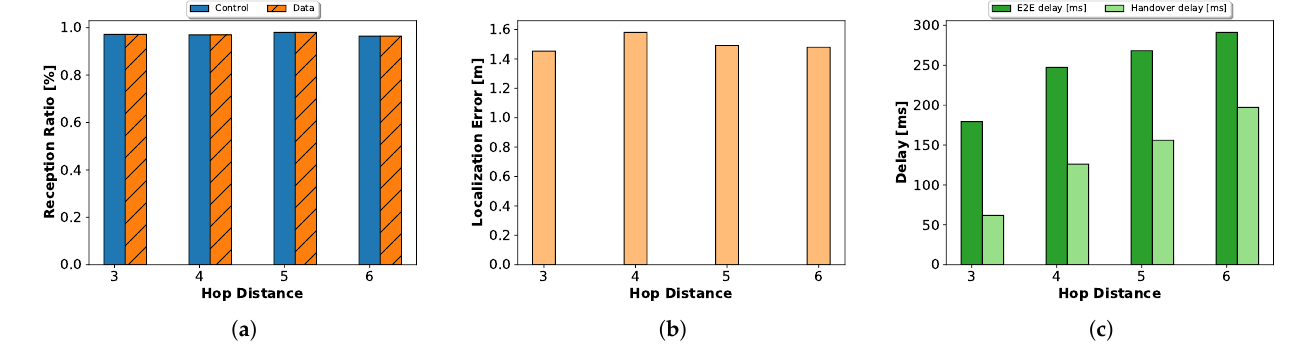
Figure 15. Simulation results for increasing distance between MN and controller with SDMob—( a ) PDR; ( b ) localization error; and ( c ) end-to-end